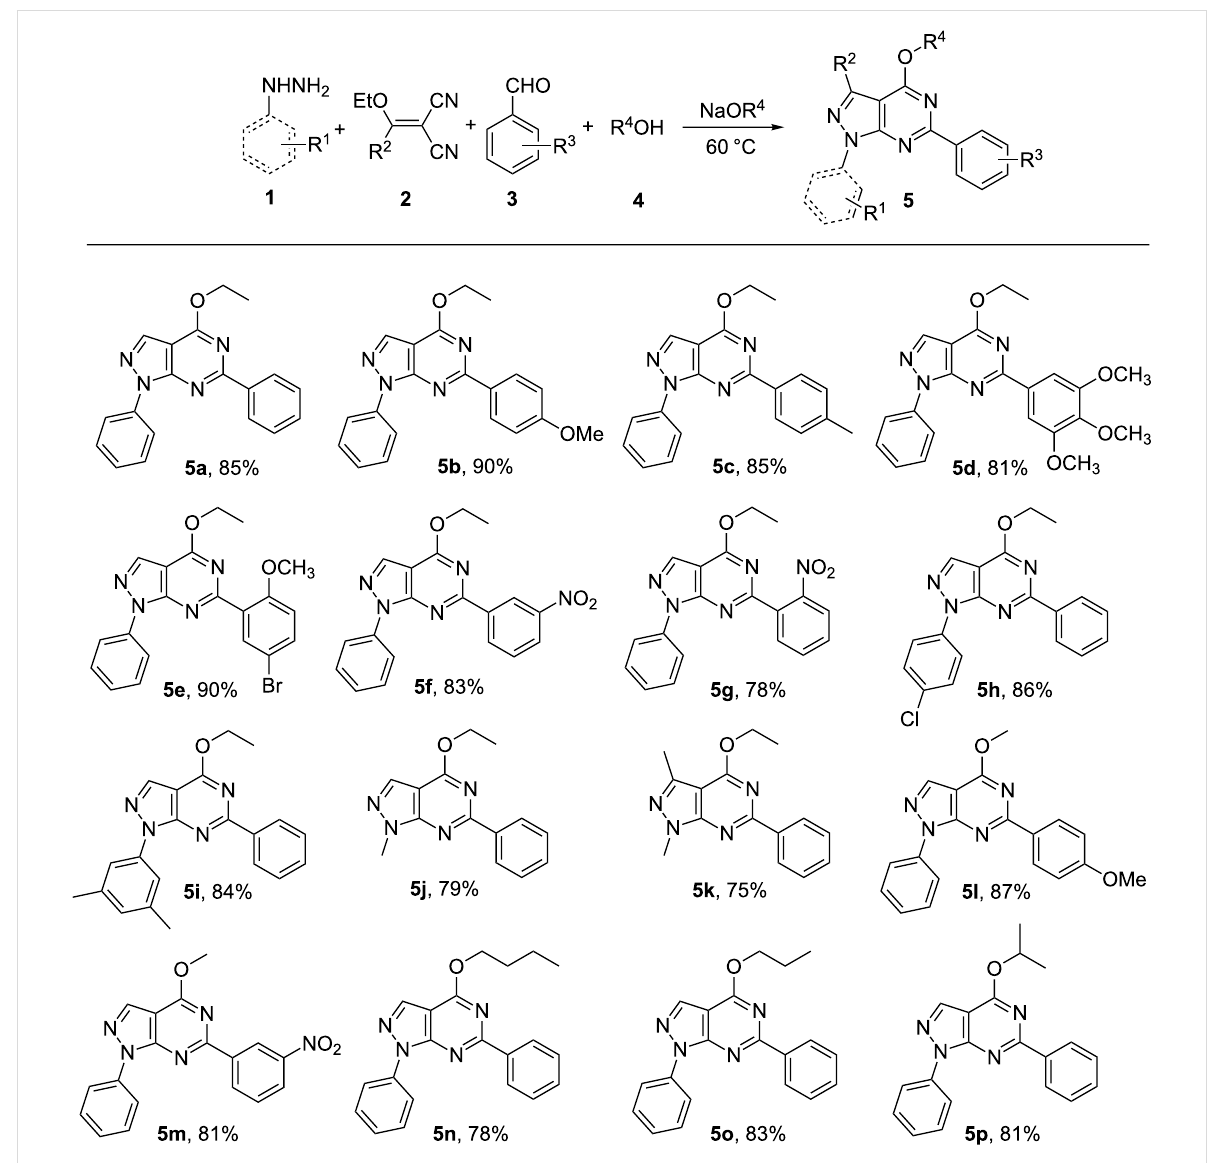
Figure 1: Four-component one-pot synthesis of 5 . Reactions conditions: 1 (1.2 mmol), 2 (1.0 mmol), 3 (1.2 mmol) and 4 (1.2 mmol) in alcohol (15